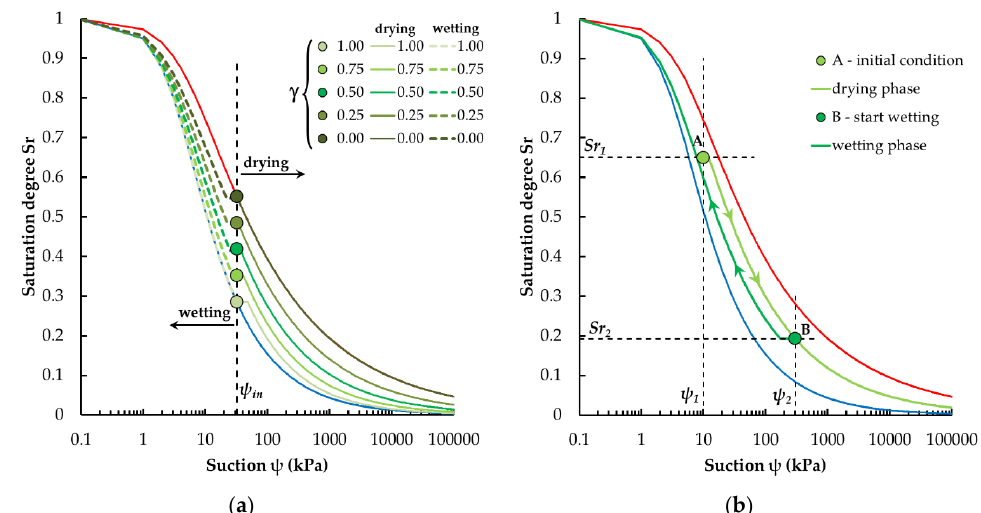
Figure 8. ( a ) Curves obtained by applying the proposed procedure, both for a drying phase and a wetting phase. ( b ) Example of the proposed procedure.